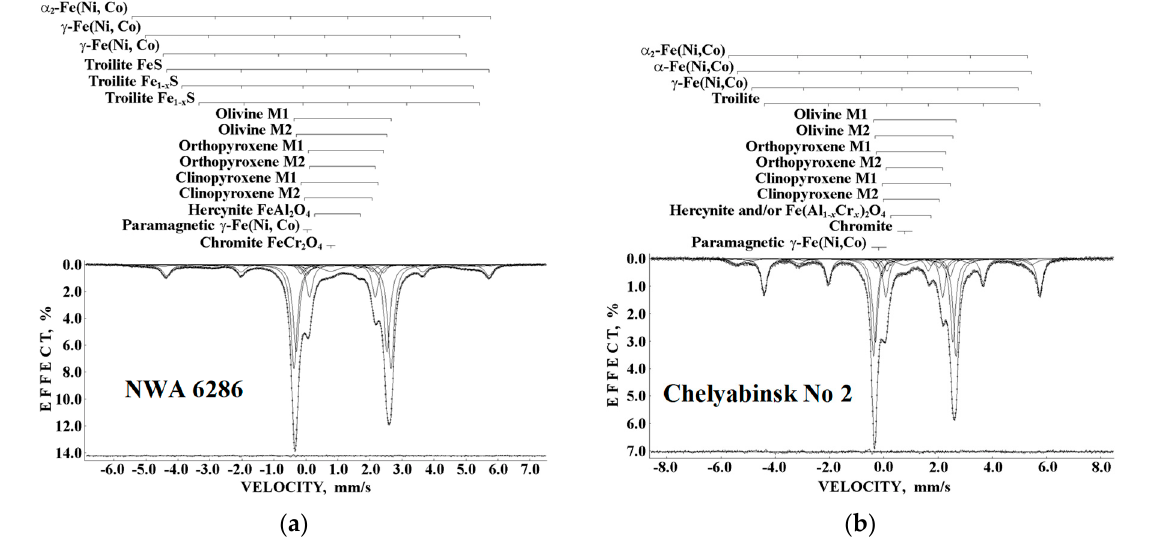
Figure 4. Mössbauer spectra of LL ordinary chondrites: ( a ) NWA 6286; and ( b ) Chelyabinsk, fragment No 2. Indicated components are the results of the best fits. The differential spectra are shown below. T = 295 K. Adopted from [13] and [21], respectively.